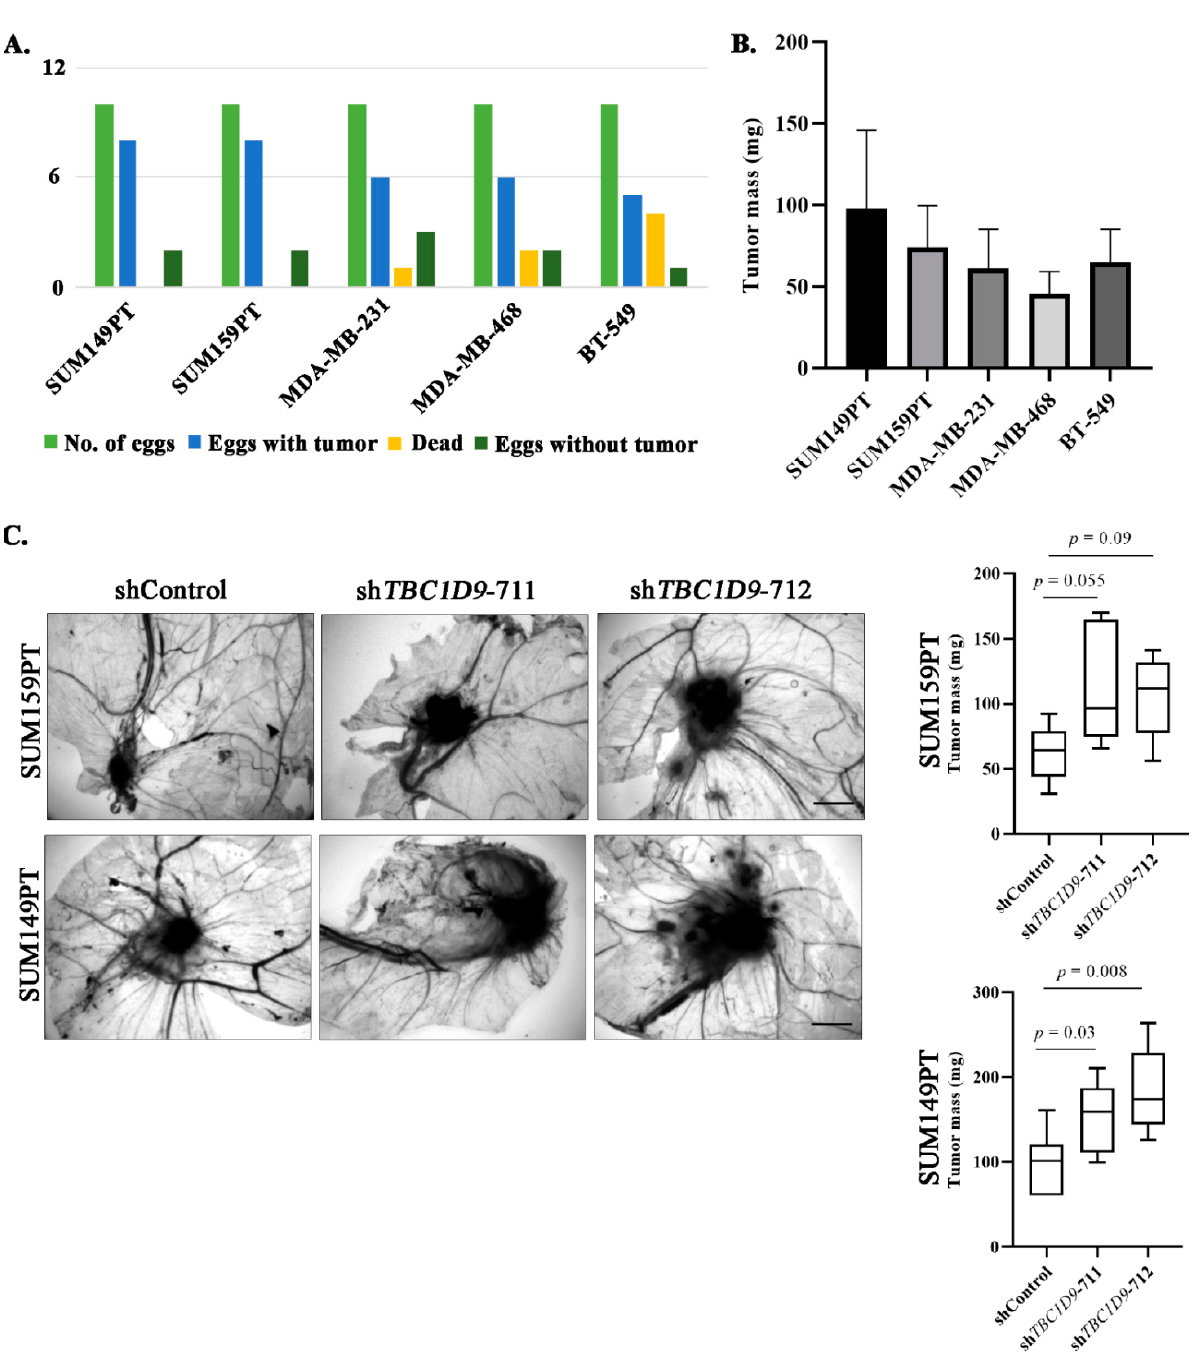
Figure 4 . Effect of TBC1D9 knockdown on BC tumor growth in an in vivo setting. Examination of different TNBC cell lines in a CAM assay to select the best model: outcomes of CAM assay ( A ) and average tumor mass ( B ). The effect of TBC1D9 knockdown on tumor growth of SUM159PT and SUM149PT in the CAM assay ( C ). Scale bar: 100 µm.